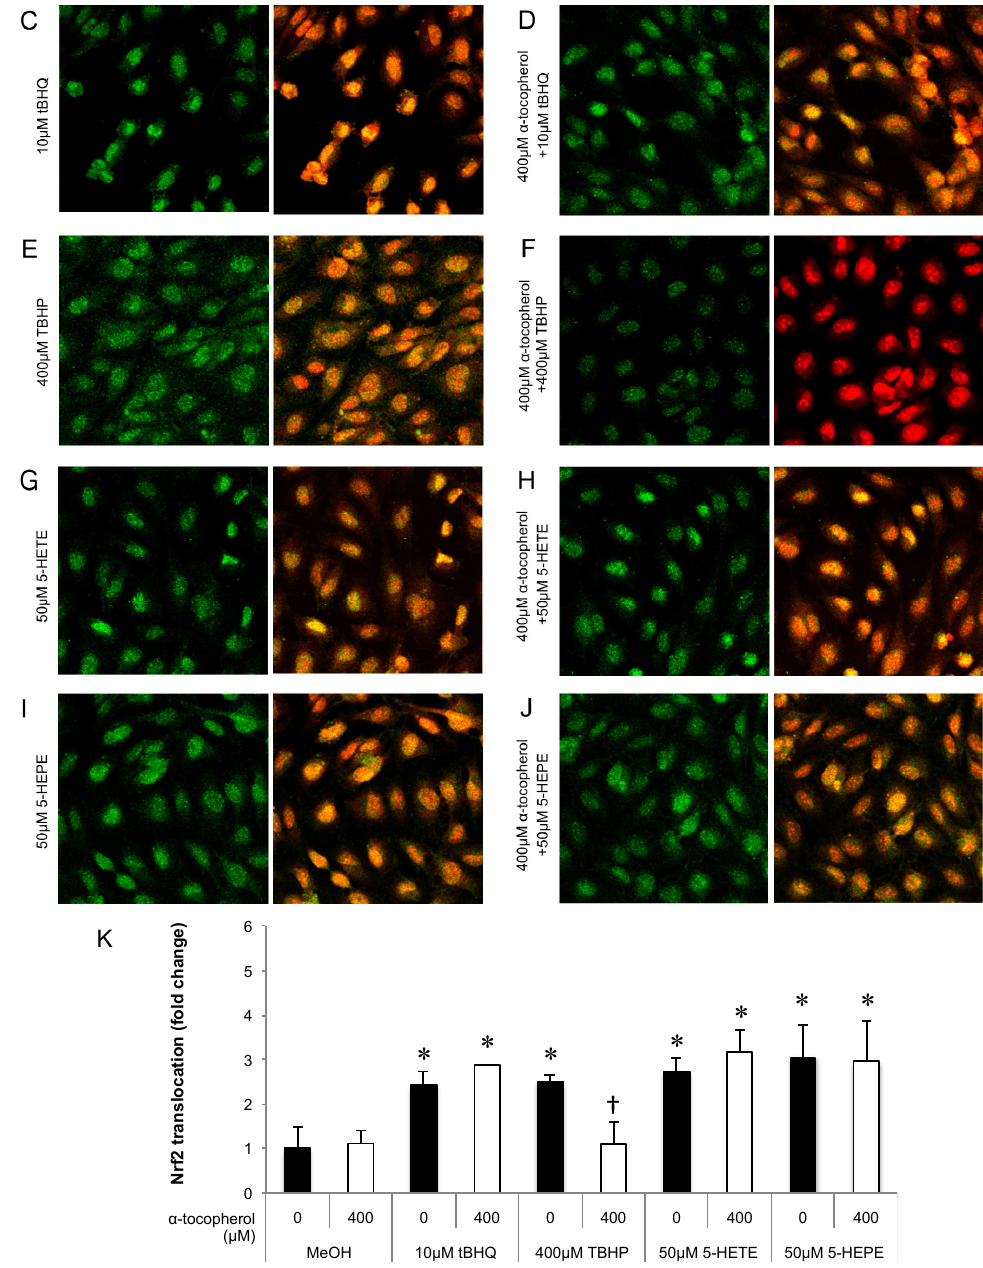
Figure 3. Effects of antioxidant treatment on nuclear translocation of Nrf2 in HUVECs. Nrf2 translocation was detected by immunostaining (green), and the nuclei were stained with PI (red). HUVECs were pretreated with or without 400 µ M α -tocopherol for 1 h and followed by incubated for 3 h with each samples: 0.5% MeOH (vehicle) ( A ); 0.5% MeOH with α -tocopherol ( B );10 µ M tBHQ ( C ); 10 µ M tBHQ with α -tocopherol ( D ); 400 µ M TBHP ( E ); 400 µ M TBHP with α -tocopherol ( F ); 50 µ M 5-HETE ( G ); 50 µ M 5-HETE with α -tocopherol ( H ); 50 µ M 5-HEPE ( I ); and 50 µ M 5-HEPE with α -tocopherol ( J ). The intensity of the green fluorescence signal in the nucleus was quantified using Image J ( K ). Data are expressed as the mean ± SD ( n = 8). * p < 0.05 compared with 0.5% MeOH. Statistics analysis was performed with one-way ANOVA followed by Tukey’s